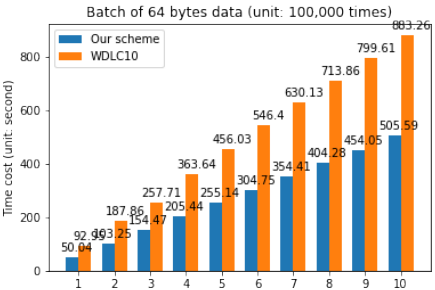
Figure 5. Time cost for our PRE scheme and WDLC10 encryption for every 100 k times of encryption of 64 bytes data on MacBook 1.3 GHz Intel Core i5.